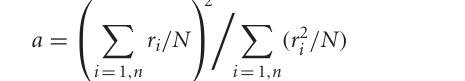
synapse onto the i ’th neuron. An introduction to autoassocia- tion, competitive, and pattern association networks is provided in the Appendices of Memory, Attention, and Decision-Making: A Unifying Computational Neuroscience Approach (Rolls,